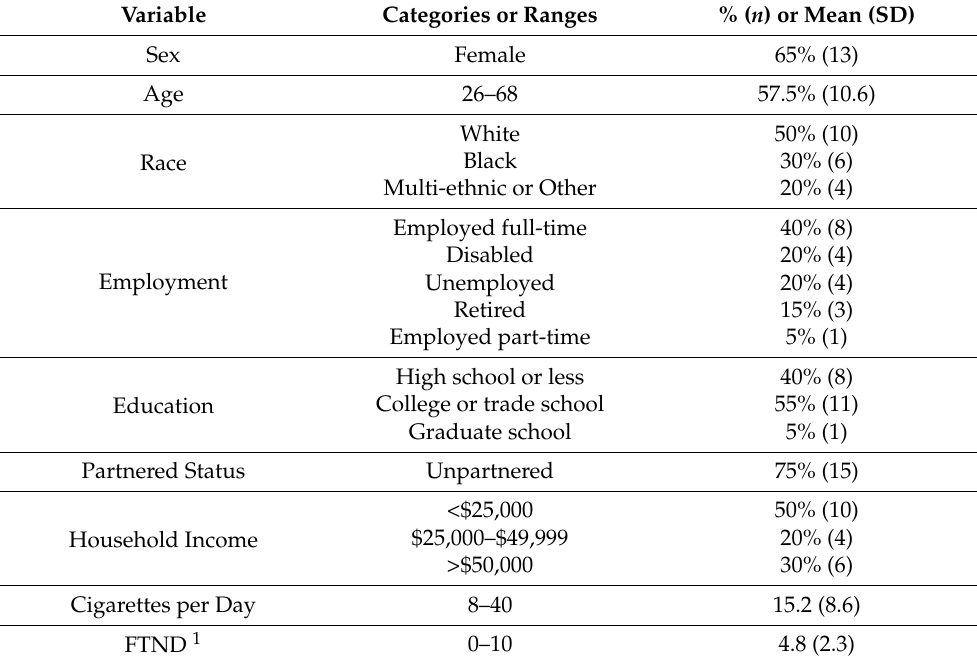
Table 1. Baseline demographic